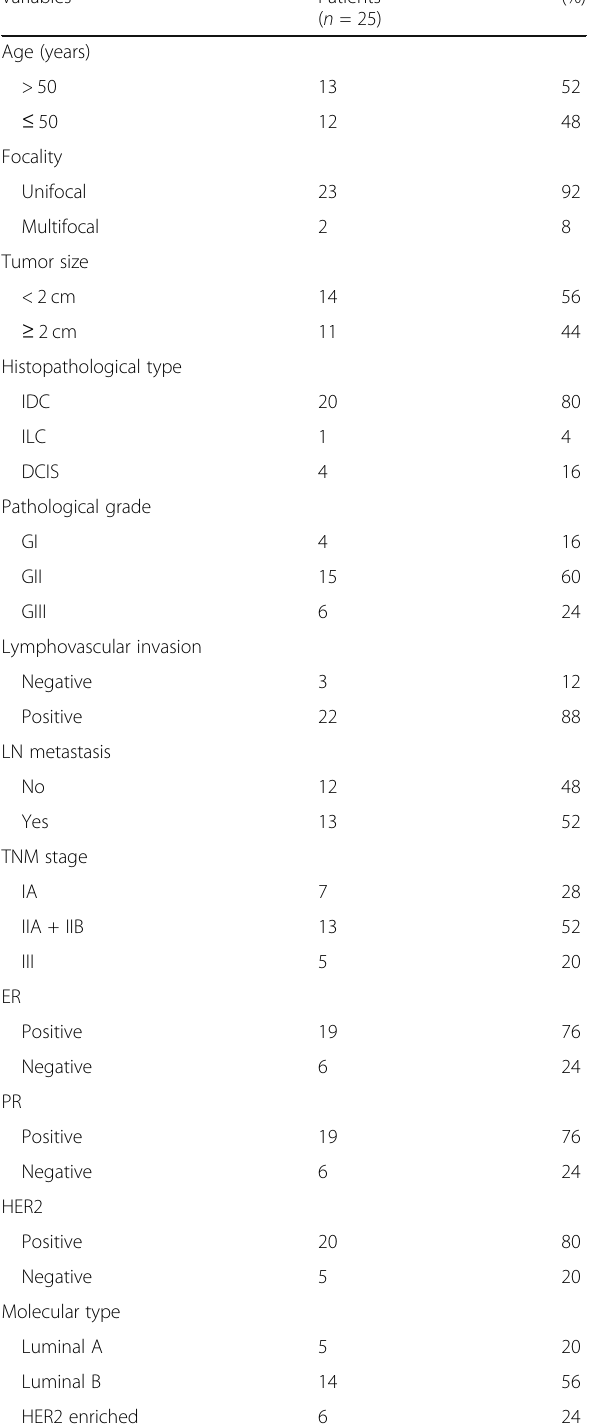
Table 1 The clinicopathological characteristics of studied patients Variables